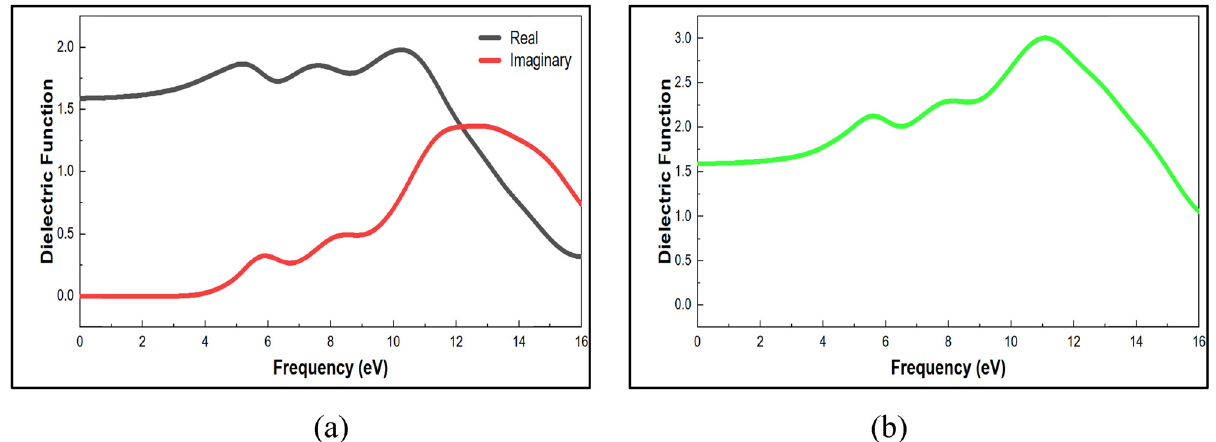
Figure 11: ( a ) Real and imaginary dielectric function optical properties of nylon 66. ( b ) Dielectric function optical properties of nylon 66